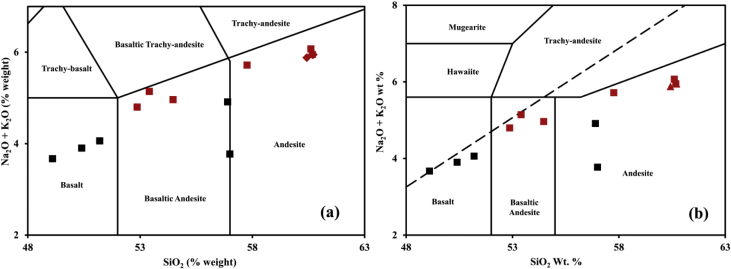
Plots of Na2O and K2O in respect with SiO2 in TAS diagram from (a) [5] and (b) [6]. Red squares indicate lava samples from the Ijen crater. Ijen crater samples from Ref. [1] are shown with black squares and Mount Blau samples are presented the red diamonds.